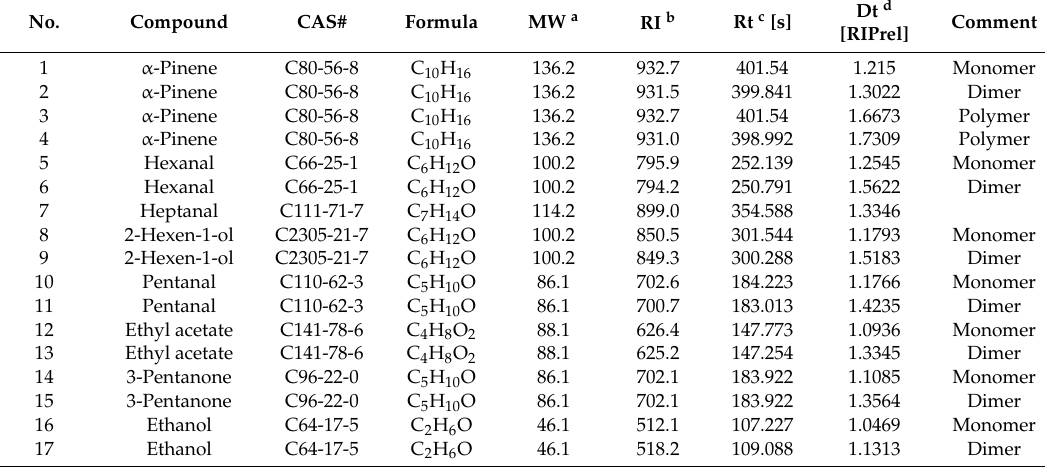
Figure 5. Imaging of volatile compounds represented by HS–GC–IMS spectra with the selected markers obtained from different kumquat samples. Table 1. Information of Qualitative Substances (40 peaks for 22 compounds).